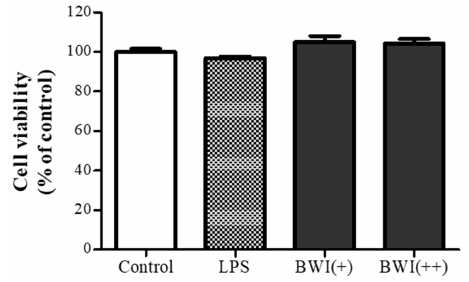
Figure 1. The viability of Caco-2 cells by LPS and BWI mix. The viability of cells was compared by treating them with LPS (1 ug/mL) and two doses of BWI mix (“+” and “++” were 1 × 10 6 and 1 × 10 7 cells/mL respectively). The data are presented as the mean ± standard deviation (SD) of three inde- pendent